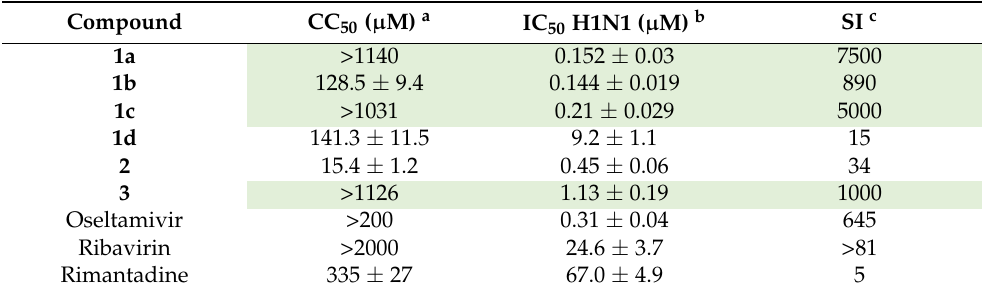
Table 1. Antiviral activity of the compounds 1a – d , 2 , 3 against influenza virus A/Puerto Rico/8/34 (H1N1) in MDCK